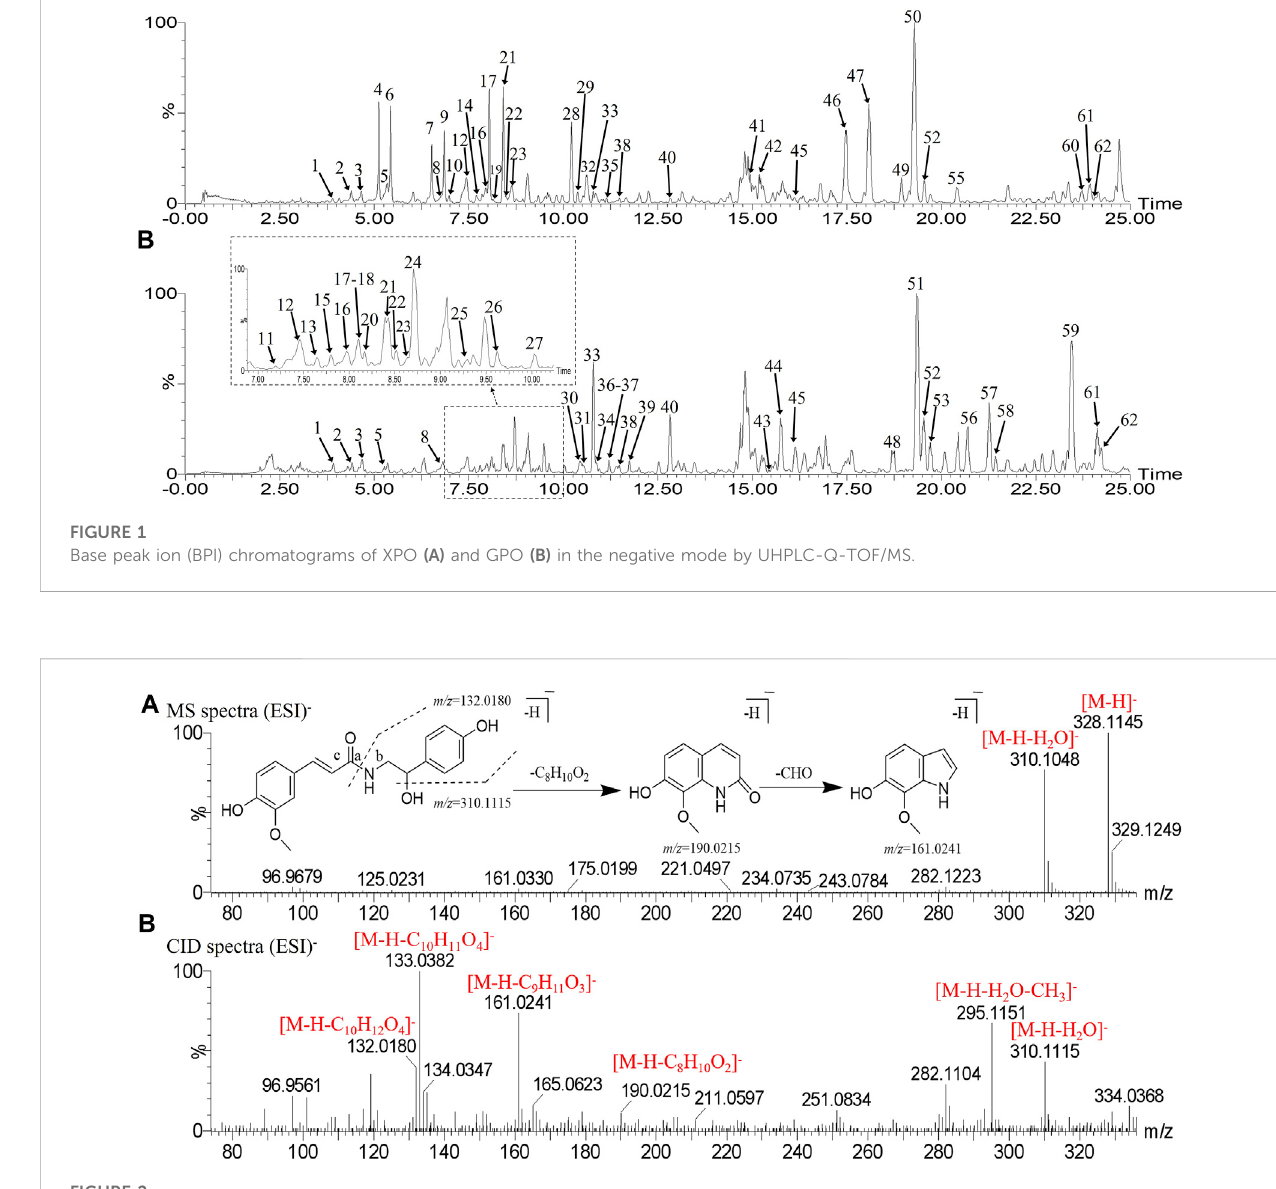
Mass spectrogram in negative mode and fragmentation pathways of N - cis -feruloyloctopamine. (A) MS spectra. (B) CID